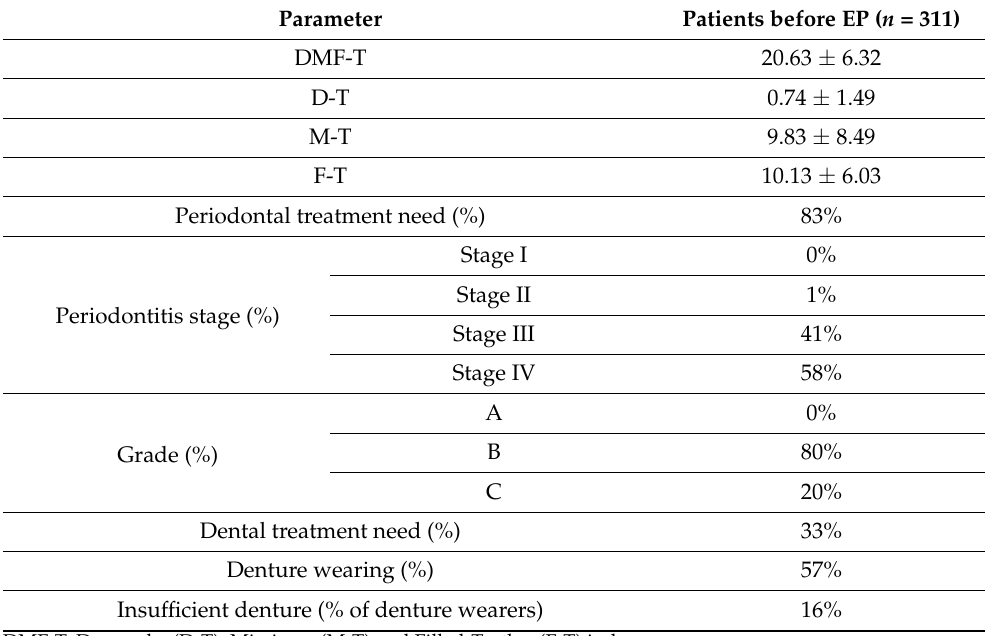
Table 3. Dental and periodontal treatment need and denture wearing of patients before endoprosthe- sis (EP). The periodontitis diagnosis is given as percentage of dentate individuals.